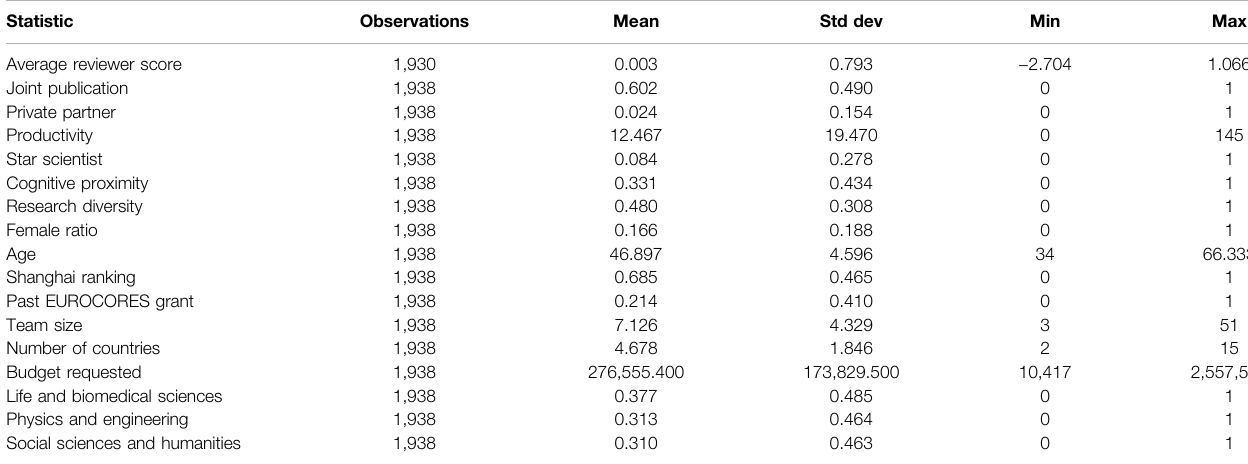
TABLE 3 | Descriptive statistics of applicants — Second Stage.